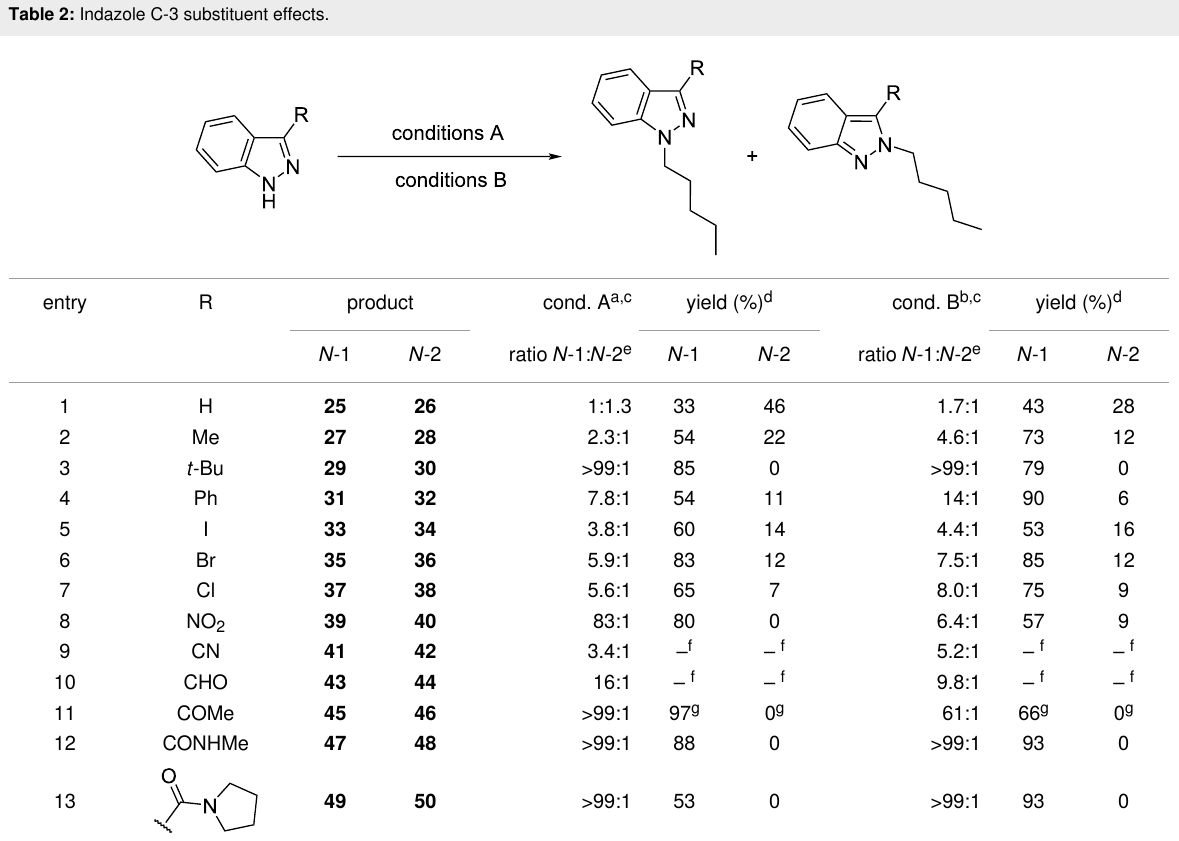
Table 2: Indazole C-3 substituent